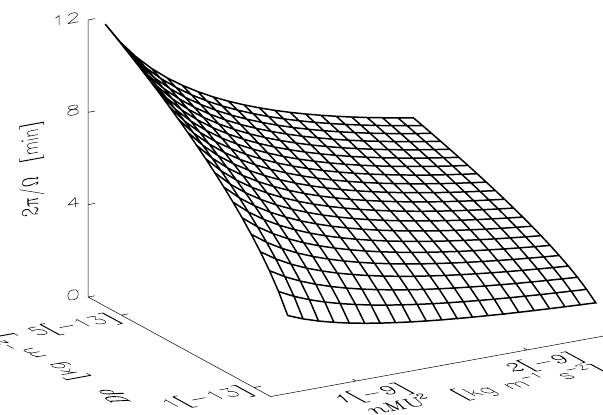
Fig. 3. The period 2 π/(cid:127) of characteristic small amplitude mag- netosphere boundary oscillations for varying solar wind pressure nMU 2 and mass loading Dρ